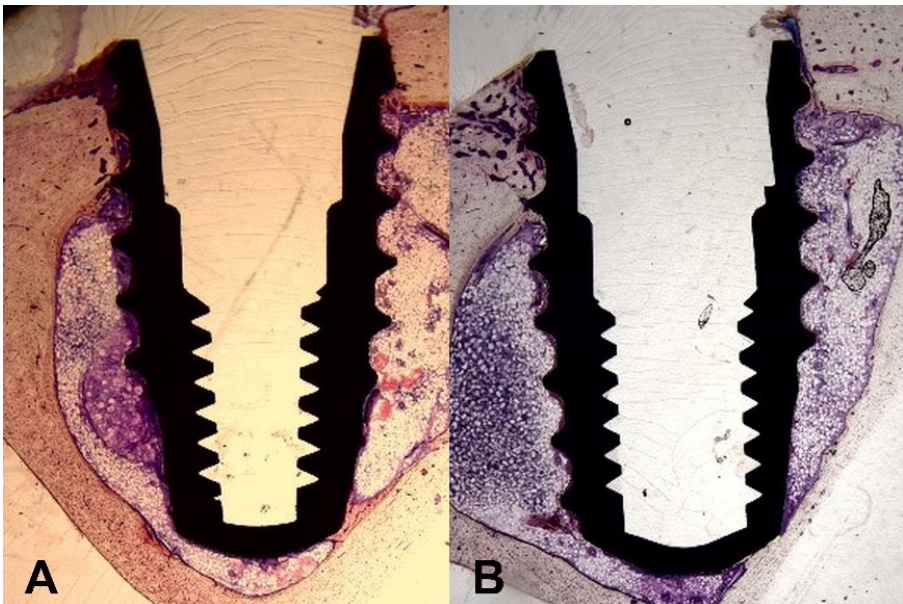
Figure 8. Comparison of histological results. ( A ) Multi-laser handpiece system (experimental group). ( B ) Conventional handpiece system (control group).